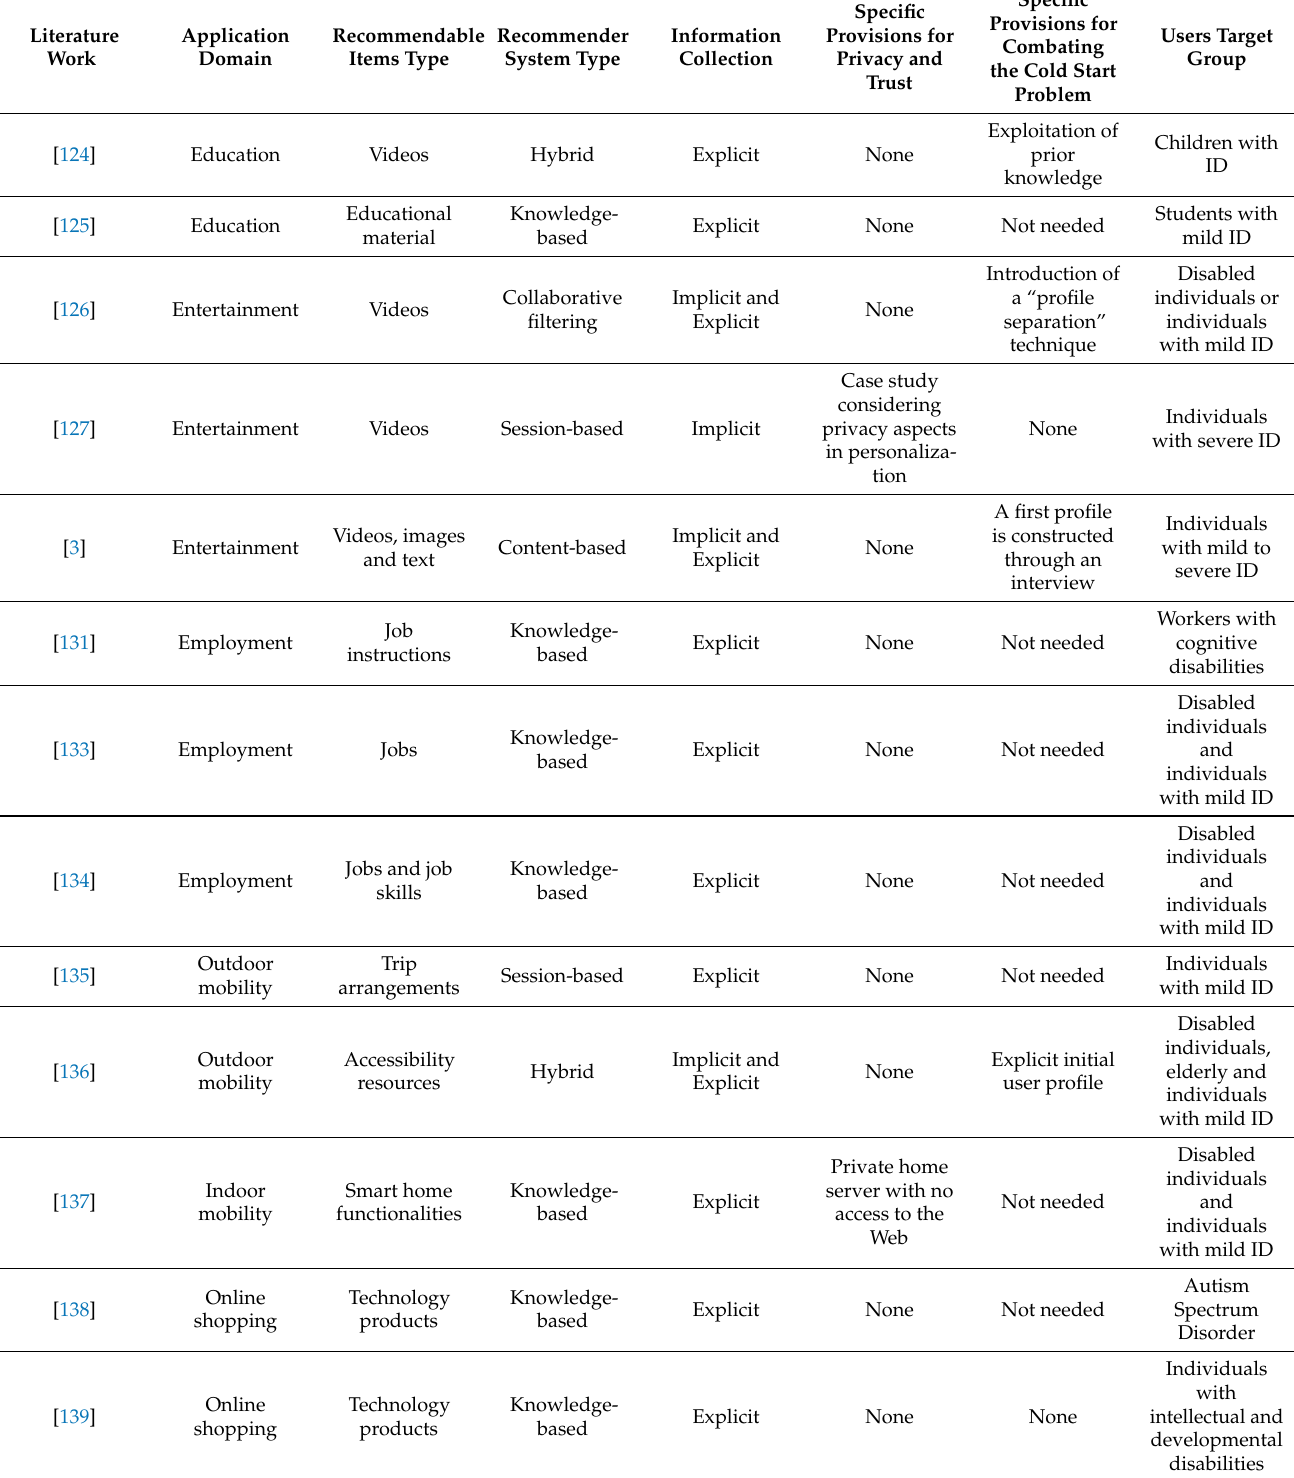
Table 2. A summary of works in the literature that discuss recommendation for individuals with